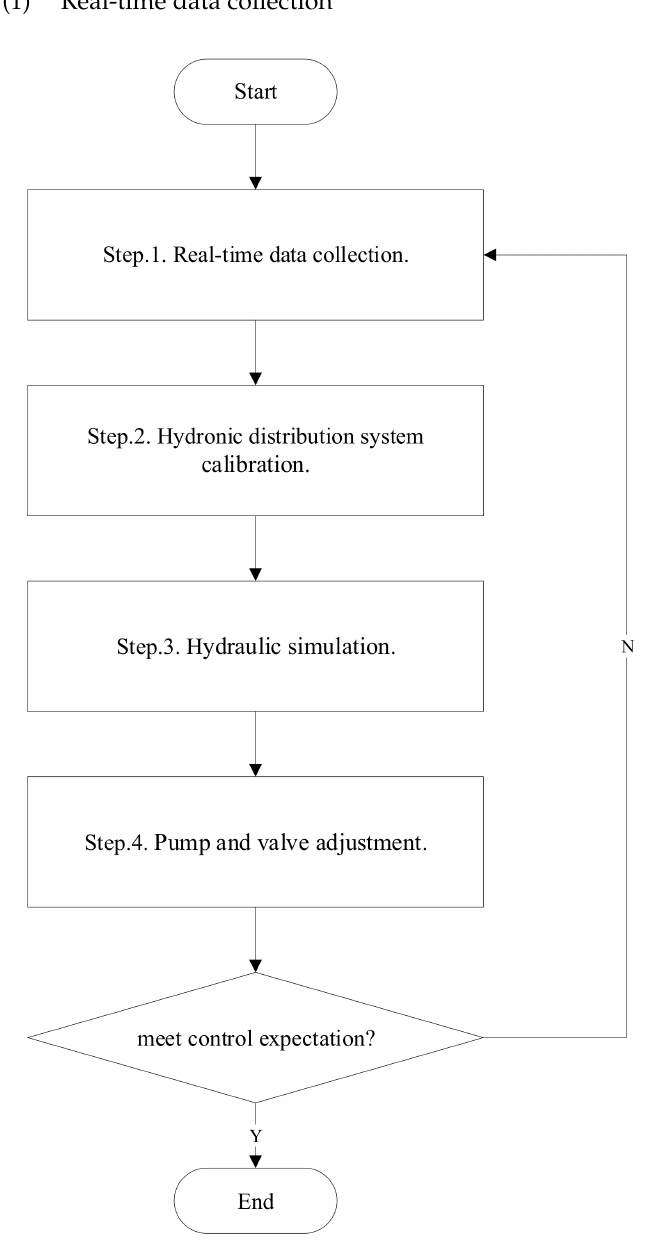
Figure 5. Flow chart of an on-site hydraulic regulation method in a chilled water